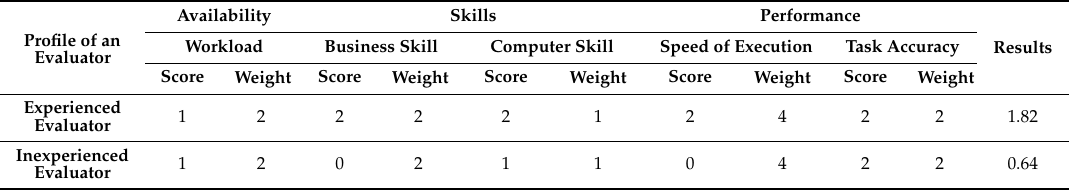
Table 2. Grid evaluation of human resource characteristics.